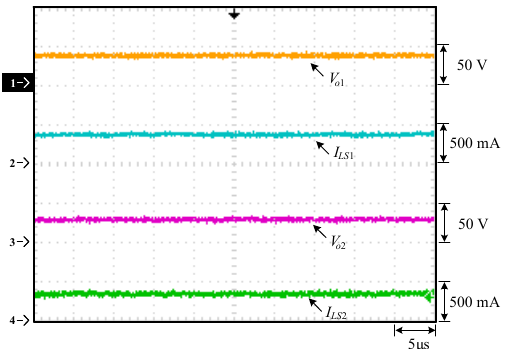
Figure 19. Measured waveforms under a difference in LED count between the two LED strings: (1) V o 1 ; (2) I LS 1 ; (3) V o 2 ; (4) I LS 2 .